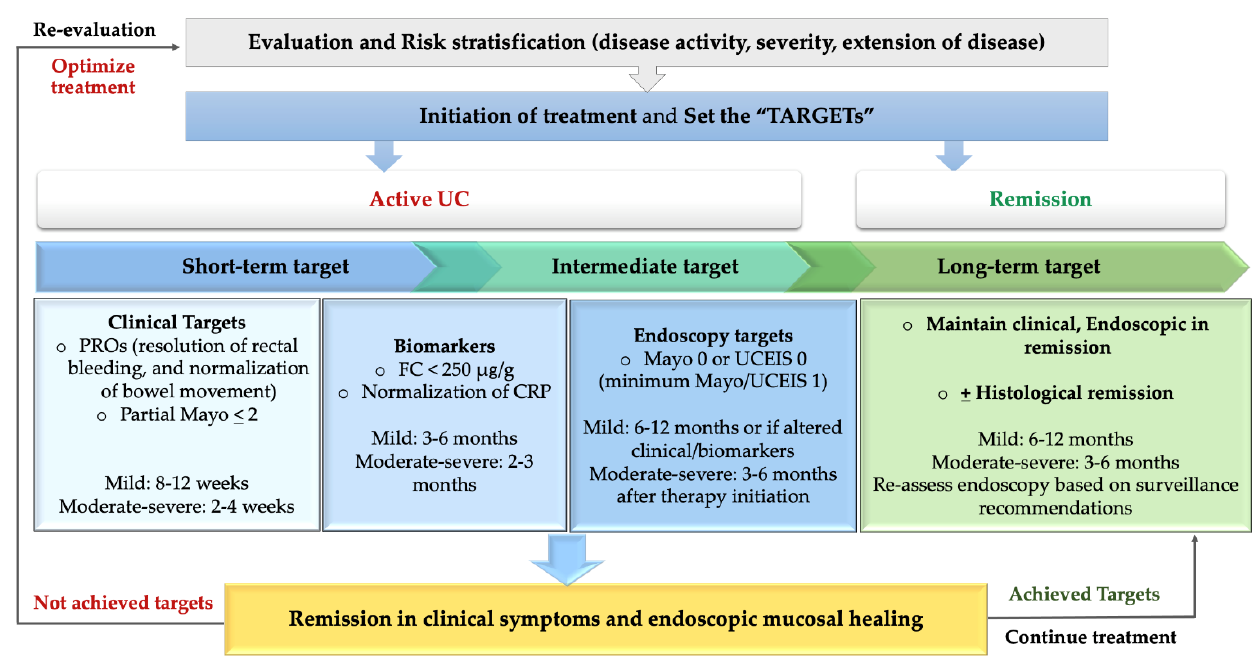
Figure 2. Proposed algorithm for “treat -to- target” appro ach in ulcerative